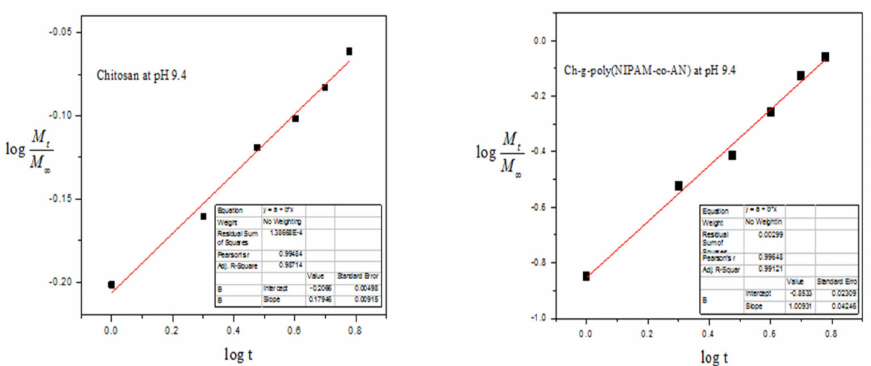
Figure 11. Release of DS kinetic study of Chitosan backbone and Chit- g -polymer (NIPAAM- co -AN) at pH